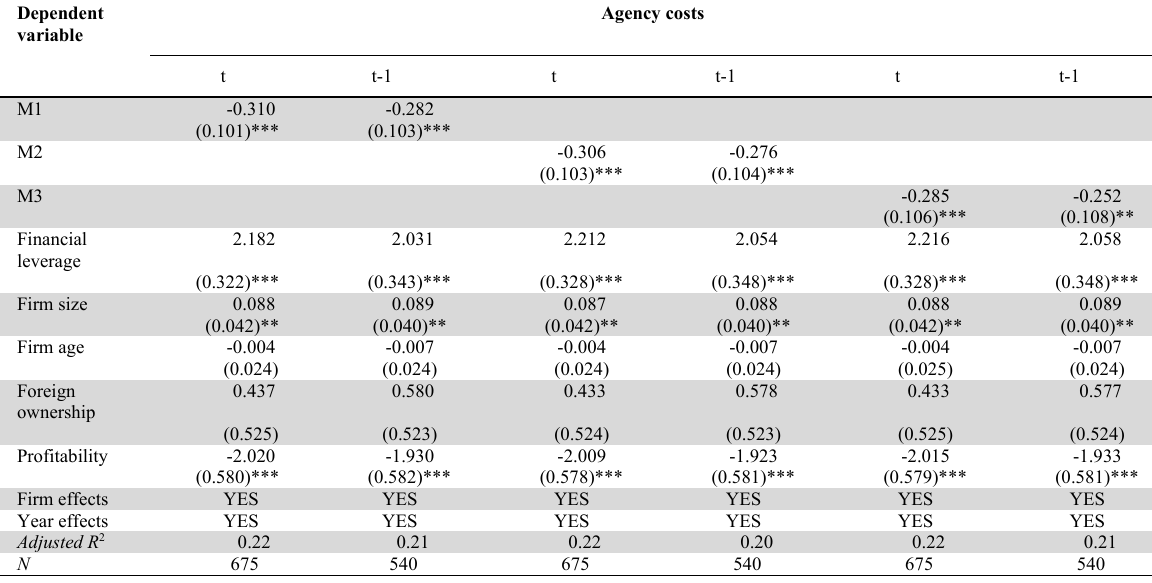
Robustness tests using one-year lagged values of independent variables (extent of conflict of interest